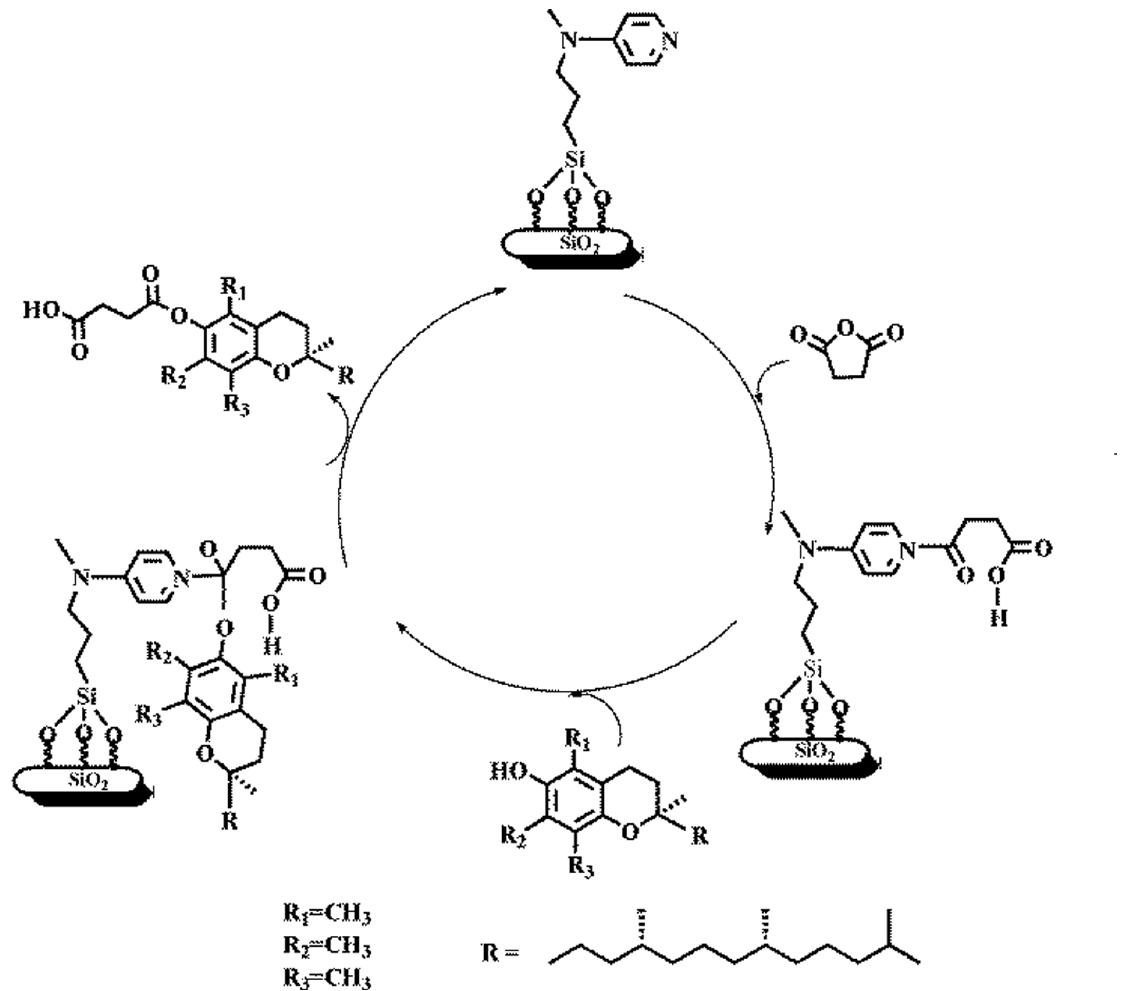
Figure 6: Proposed mechanism for the synthesis of α-tocopherol succinate using NS-DMAP in hexane and